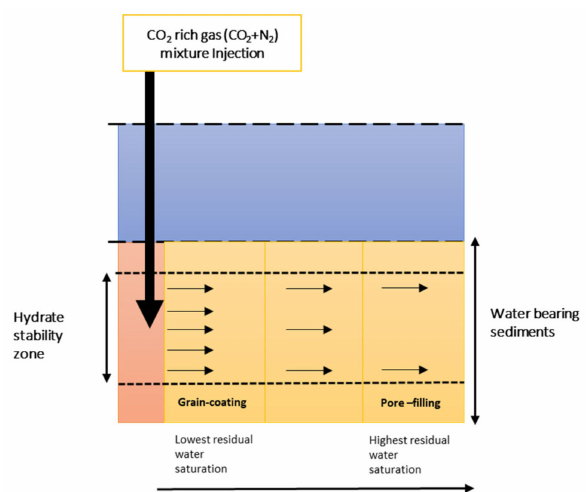
Figure 9. Conceptual framework suggesting di ff erent relative gas permeability due to changes in hydrate morphology from grain coating (near injection well) to pore filling (away from the injection well) caused by the di ff erence in residual water